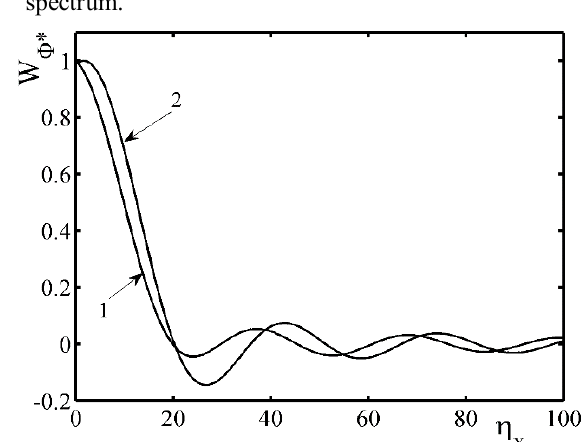
Figure 4: Normalized correlation function of the phase fluctuations versus for the Gaussian spectrum.